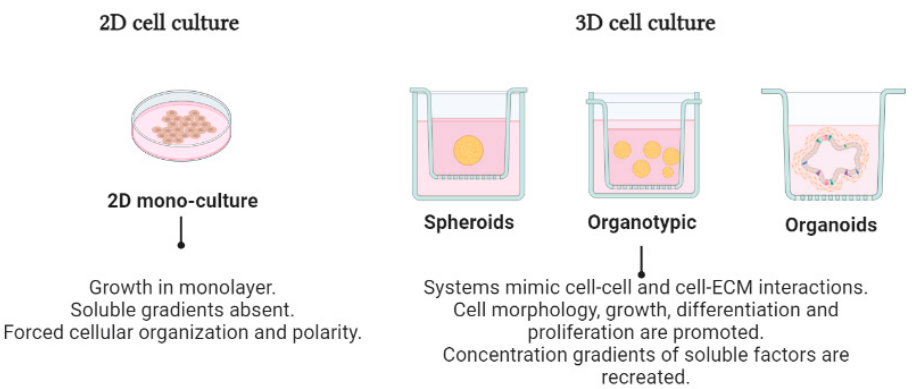
Figure 1. Characteristics of 2D and 3D cell cultures. Cells cultured in conventional 2D monolayers ( left ) exhibit a flat shape that does not accurately represent the morphology of the cells found in tumors. In contrast, cancer cells cultured in a 3D system ( right ) grow over a scaffold of ECM proteins that partially resemble the microenvironment, mimicking some cellular features of the in vivo condition; therefore, they are more appropriate for drug testing and gene expression studies.